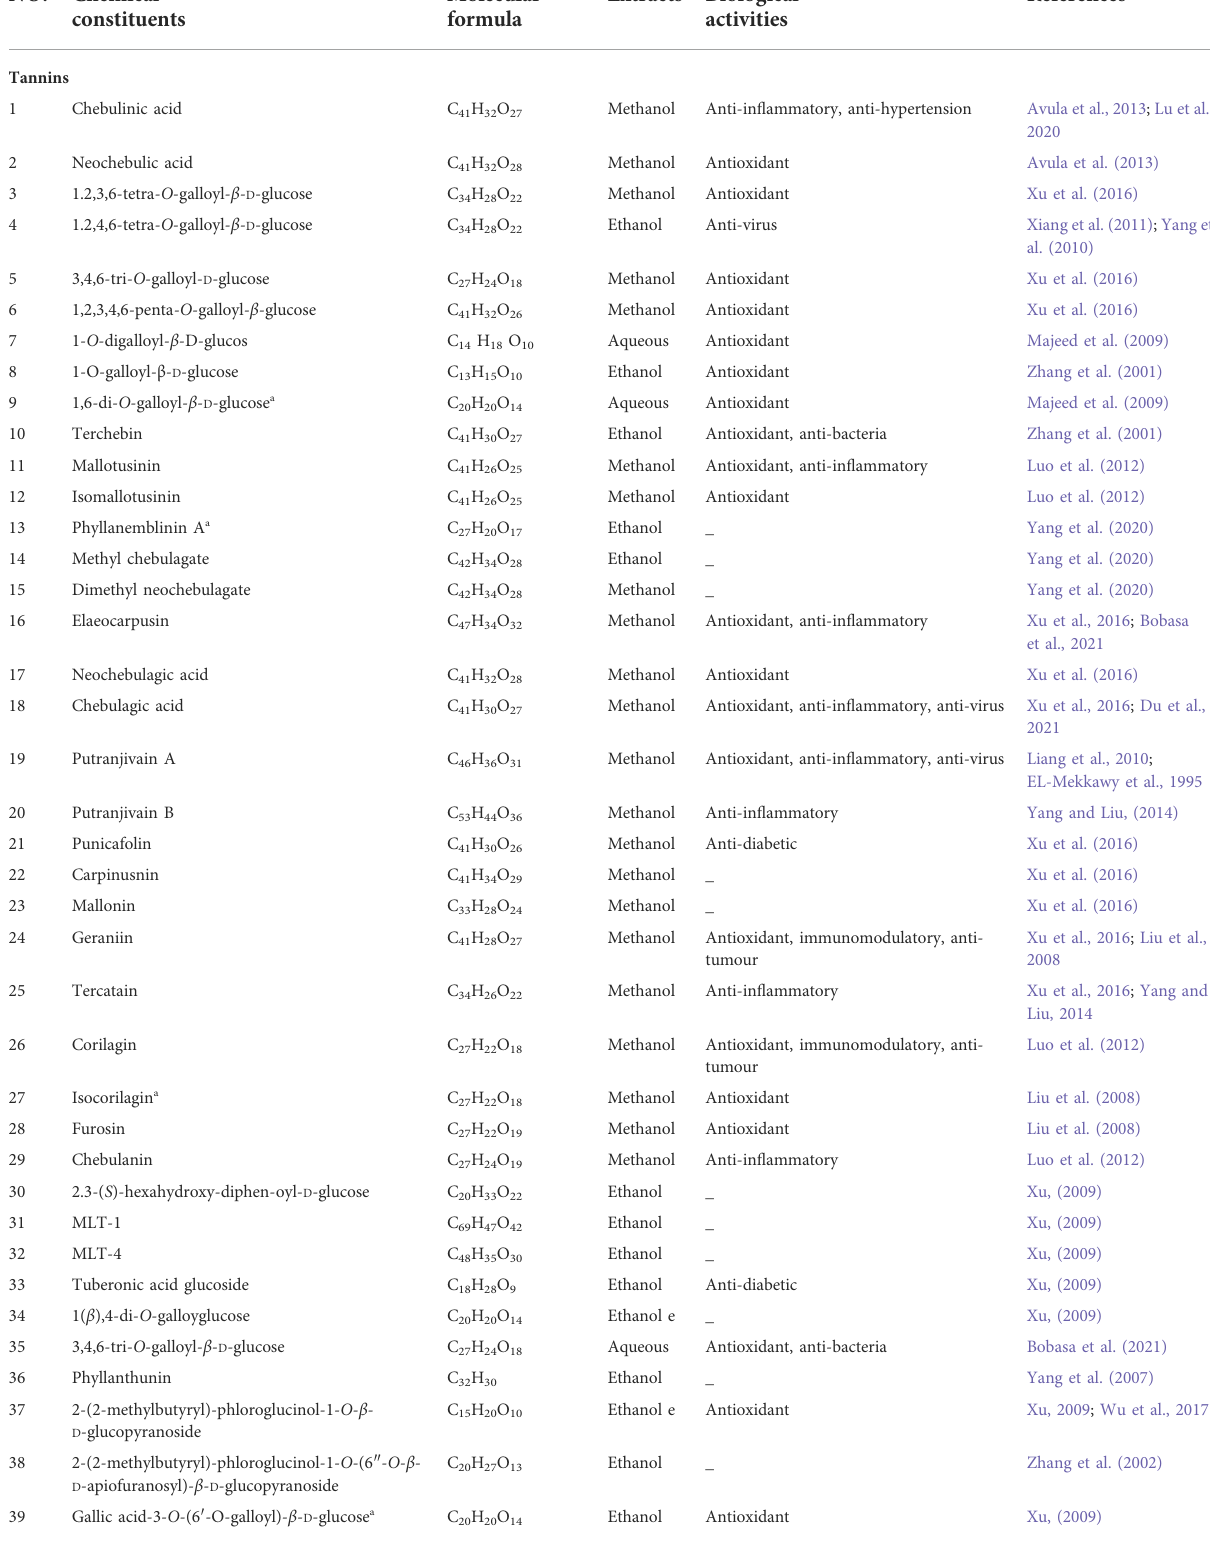
TABLE 1 Major chemical components isolated and structurally identi fi ed from